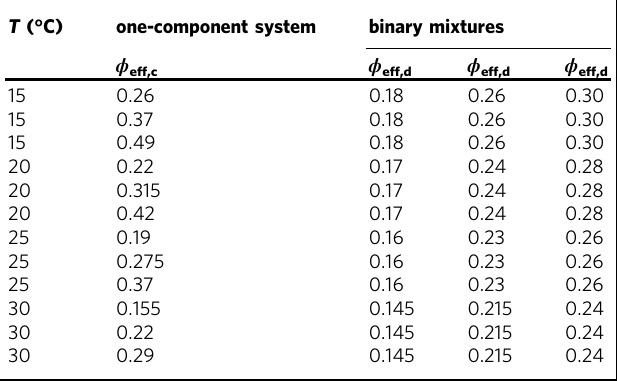
agreement with experimental data is found, it is checked a pos- teriori that the estimated values are very reasonable and obey a roughly linear relation to temperature, analogously to U cc (Sup- plementary Fig. 5, Supplementary Note 5). Table 1 Summary of effective volume fractions for all samples at all temperatures T (°C) one-component system binary mixtures